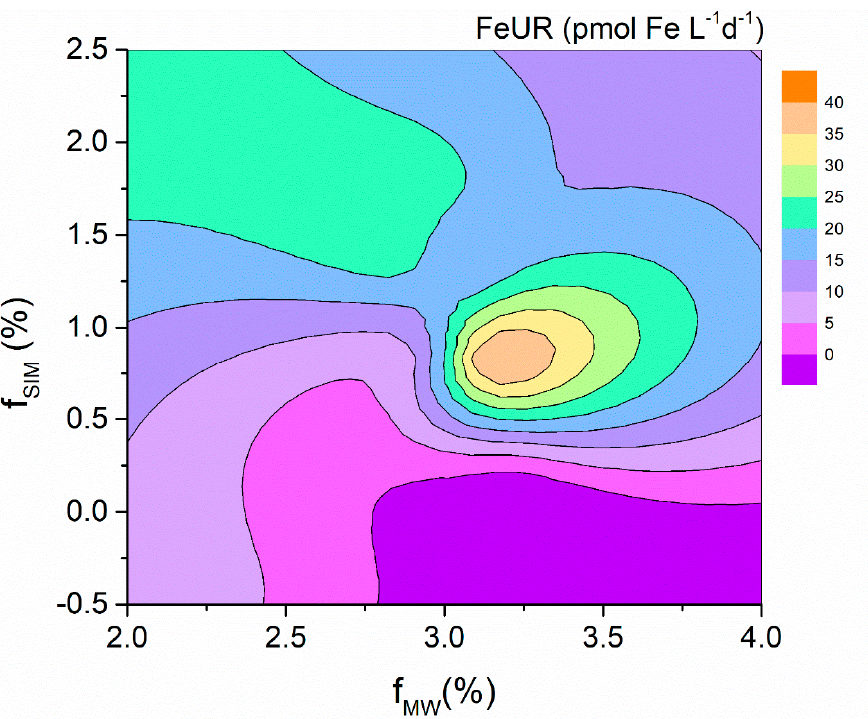
Figure 10. The FeUR variations with the f MW and f SIM .